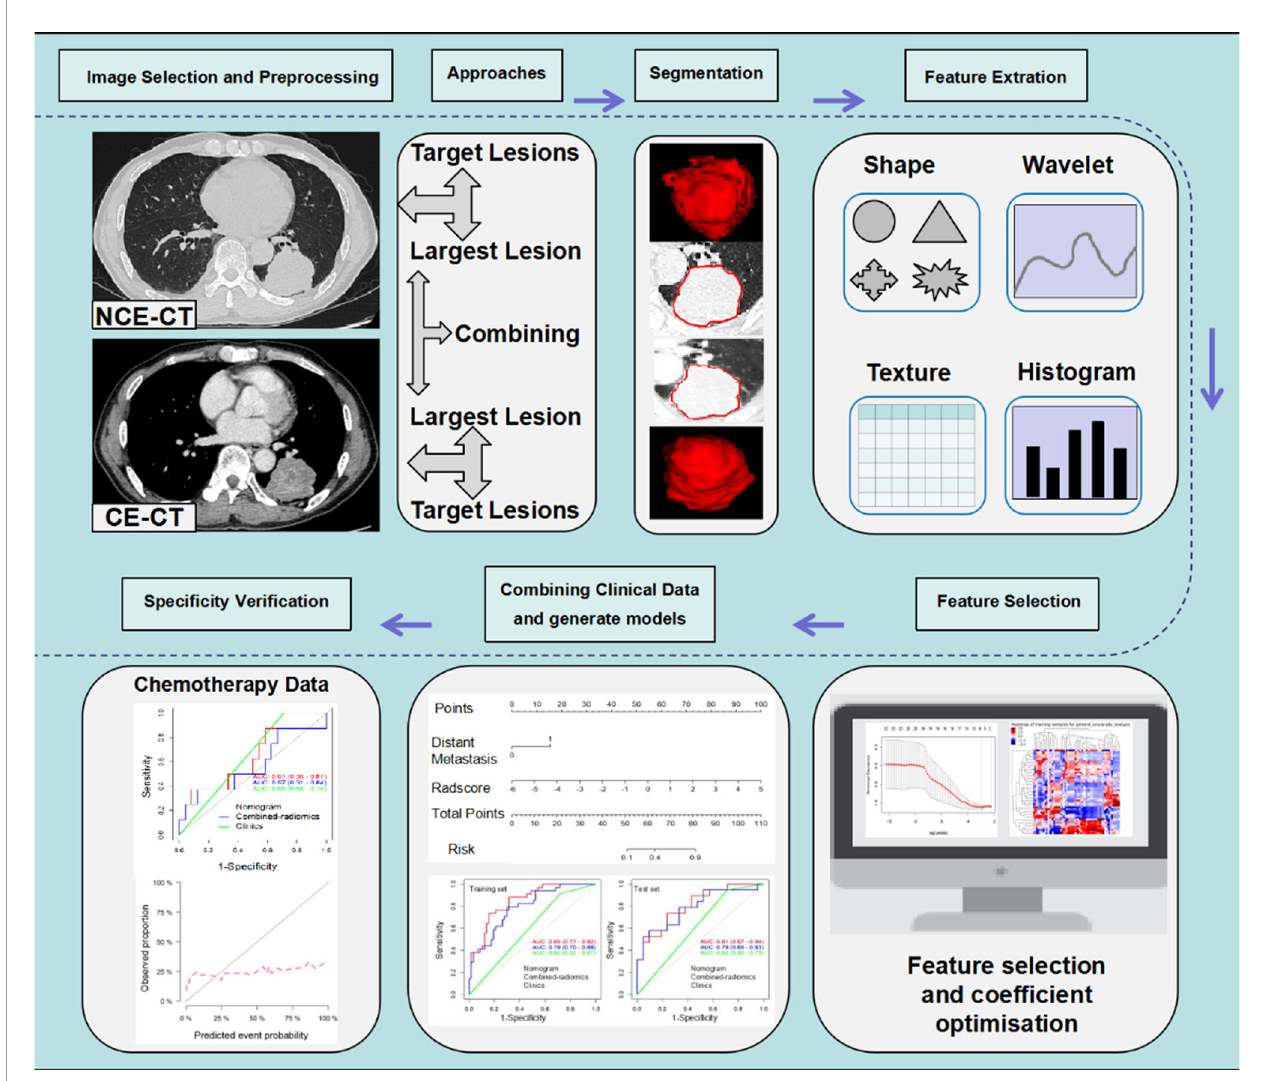
FIGURE 1 | Radiomics work fl ow. The work fl ow presents a summary of data collection, study approaches and semi-automatic delineation, modeling schemes of radiomics and speci fi city veri fi cation. NCE-CT, non contrast enhanced CT; CE-CT, contrast enhanced